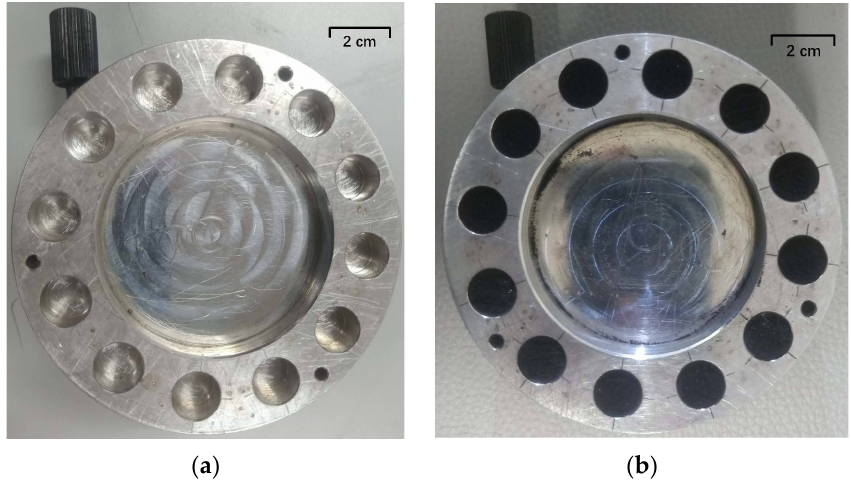
Figure 3. Plot of the mold during experiments. ( a ) unfilled mold; ( b ) mold filled with pulverized